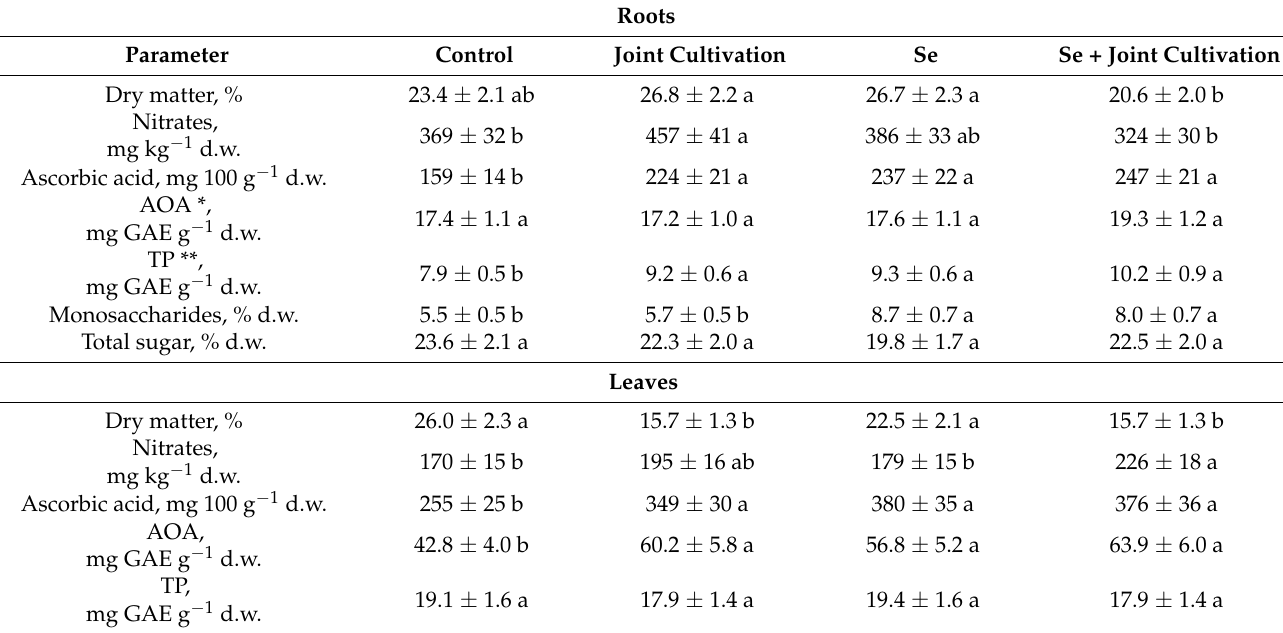
Table 4. Biochemical parameters of horseradish ( Armoracia rusticana ) roots and leaves.